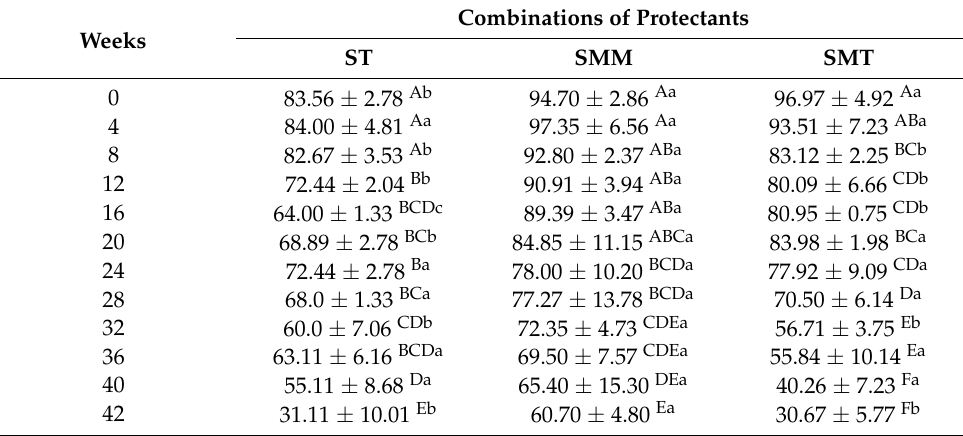
Figure 4. Changes in the survival rate of freeze-dried S. cerevisiae 88-4 during long-term storage under refrigerated conditions. ST, skim milk/trehalose; SMM, skim milk/maltose/maltitol; SMT, skim milk/maltose/tween 40. Table 2. Effect of various protectant compositions on survival rate of freeze-dried S. cerevisiae 88-4 during long-term storage under refrigerated